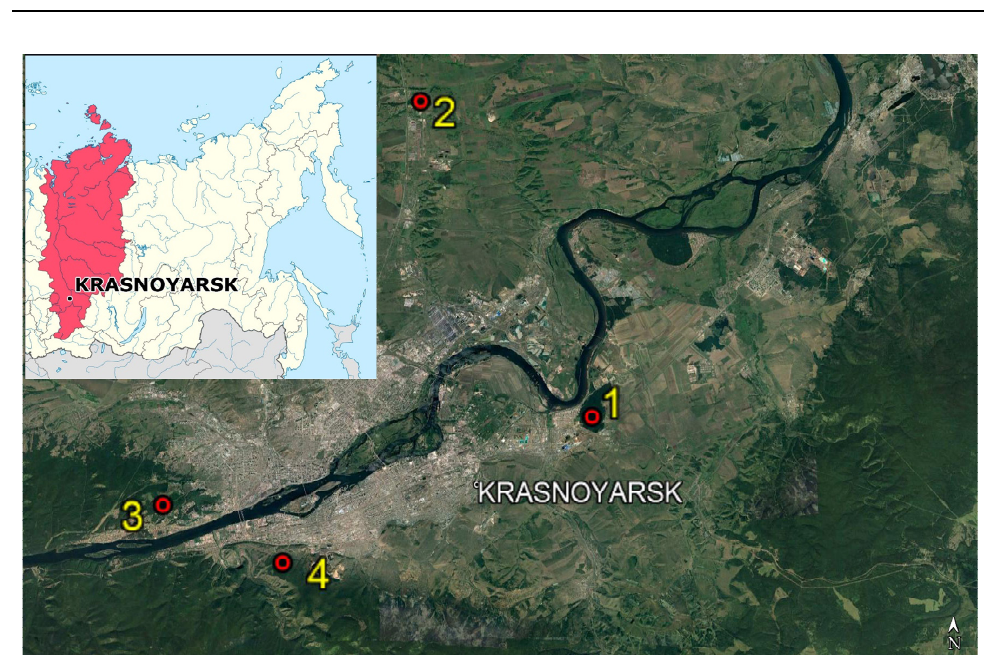
An increment borer was used to extract core samples from all trees on the sample plots. The tree ring width d(t) in year t was measured on the polished surfaces of the core samples in the field of view of the microscope in the “Lintab 5 Tree-RingStation” (RINNTECH ® ) (version No. 5) with an accuracy of 0.1 mm. The dating of tree rings was carried out visually, using graphs in the TSAP-WinTM (RINNTECH ® ) software, and con- trol of the dating was performed using the COFECHA program (version 6.0P) from the dendrochronology program library, DPL [51]. Figure 1 shows the positions of sample plots.